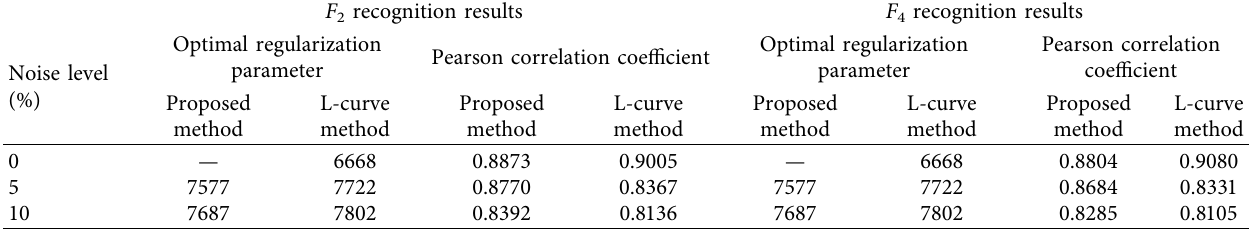
Table 3: Comparison of the calculation results for F 2 and F 4 obtained using the L-curve method and the proposed method.